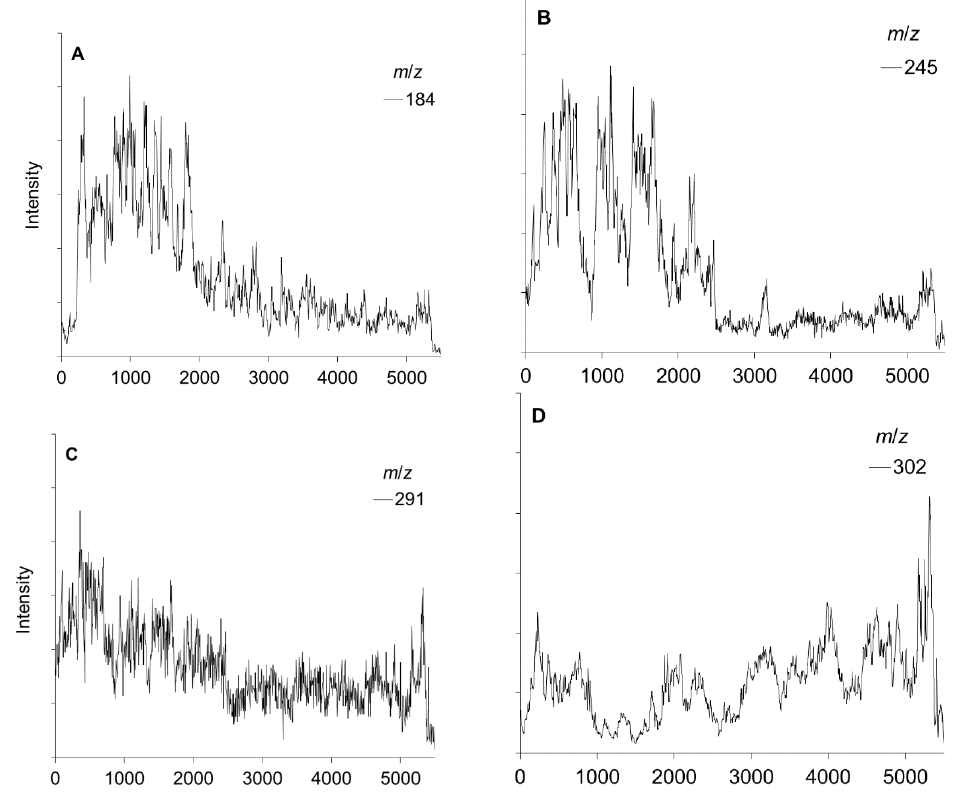
Figure 9. Ion intensities of m / z at 184 ( A ), 245 ( B ), 291 ( C ), and 302 ( D ) representing living cell membranes, stilbene glucoside astringin, (+) − catechin, and abietic acid, respectively, obtained from ToF-SIMS spectra of the radial-longitudinal surface of a frozen-hydrated, fungus-inoculated Norway spruce sapling. The specimen is the same as that shown in Figure 8. The ion intensity values of three consecutive pixels were averaged, and the results are shown as a function of the distance ( µm ) from the inoculation site. In wounded specimens, (+) − catechins and stilbene glucosides were not induced or present in the newly formed callus tissue (Figures 10 and 11; at the distance of 0 – 500 µm from the cambium towards the outer bark). The patterns of polyphenolic compounds from the cambium to the outer layers of the cortex and epidermal tissue closely followed those detected in mature spruce phloem (Figures 10 and 11 vs. Figure 5).